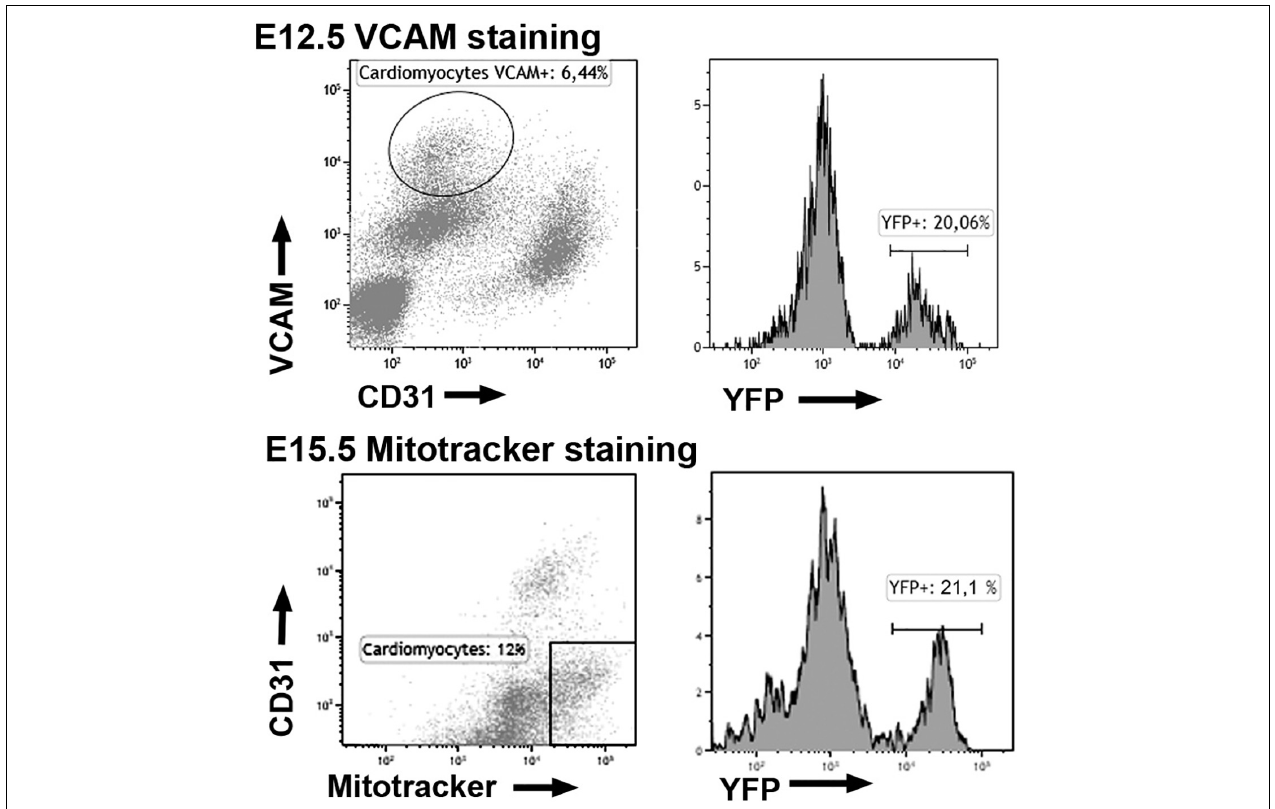
FIGURE 3 | Expression of the YFP reporter in cardiomyocytes of the WT1 Cre ; R26R EYFP lineage tracing line. Representative cytograms obtained from the analysis of 11 embryos. The fraction of cardiomyocytes expressing the WT1 lineage reporter (YFP+) is shown.